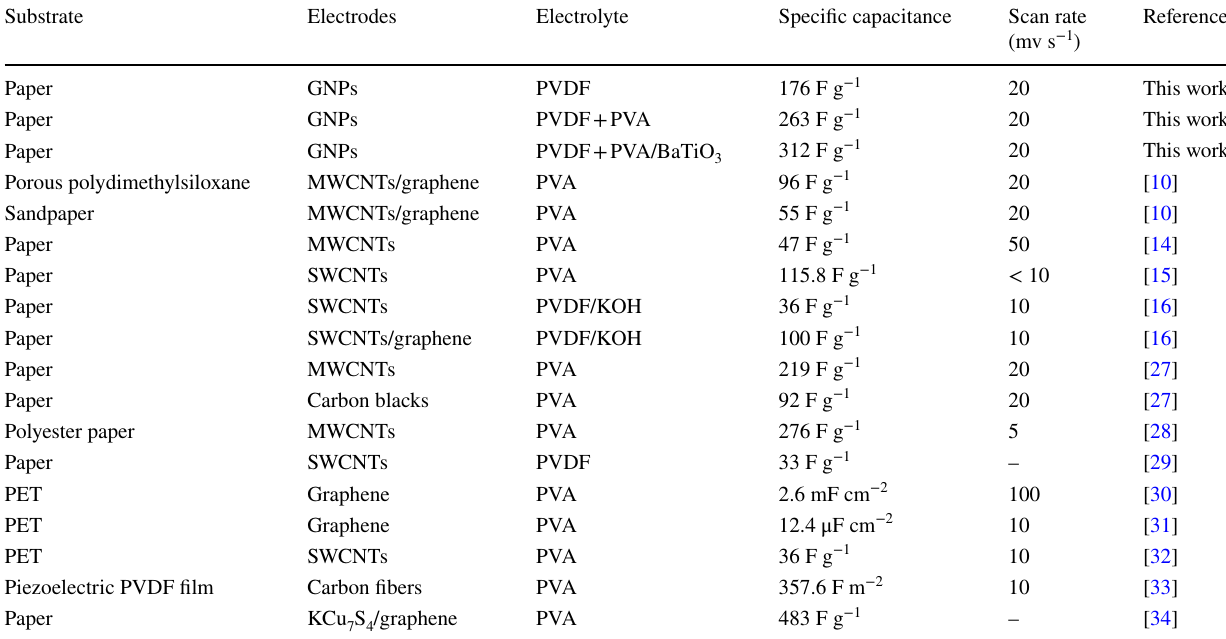
Table 1 Comparison of different supercapacitor based on the PVDF and PVA gel